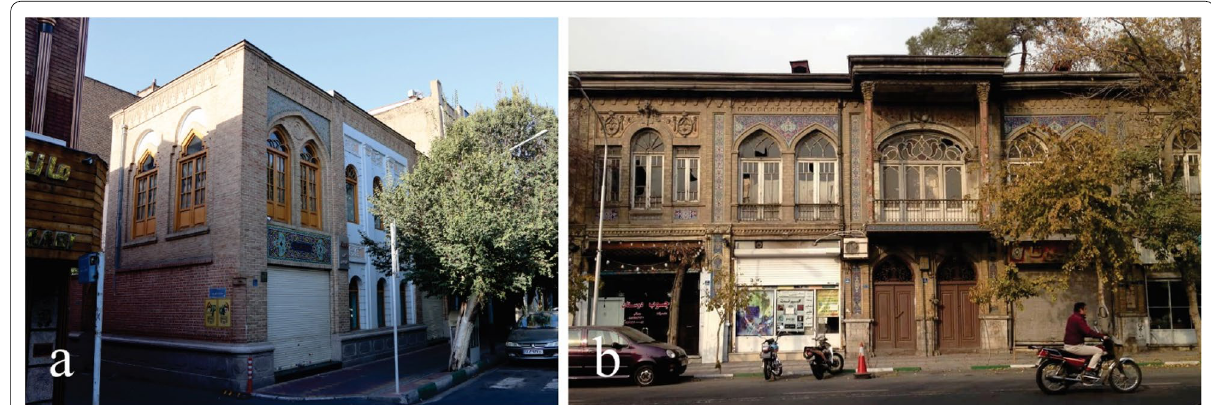
Fig. 7 Urban facades of Qajar period in Tehran; a Sarhang Sakhaie St; b Shariati